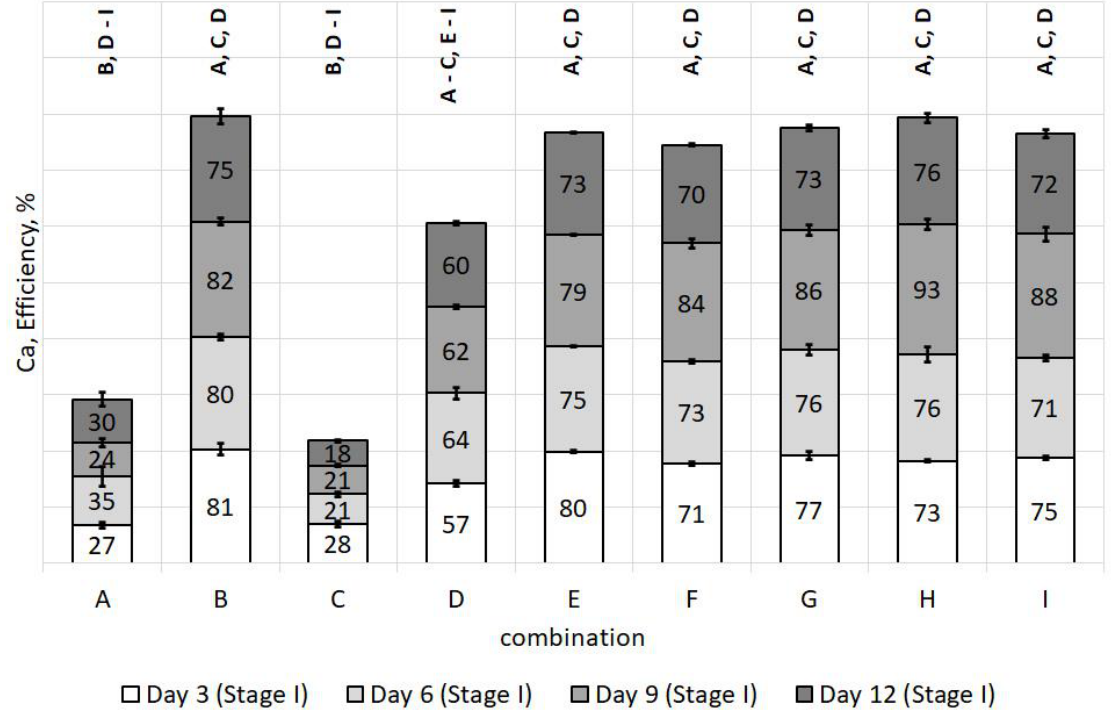
Figure 7. Effectiveness of Ca release to the dissolved fraction of leachate (Stage I).